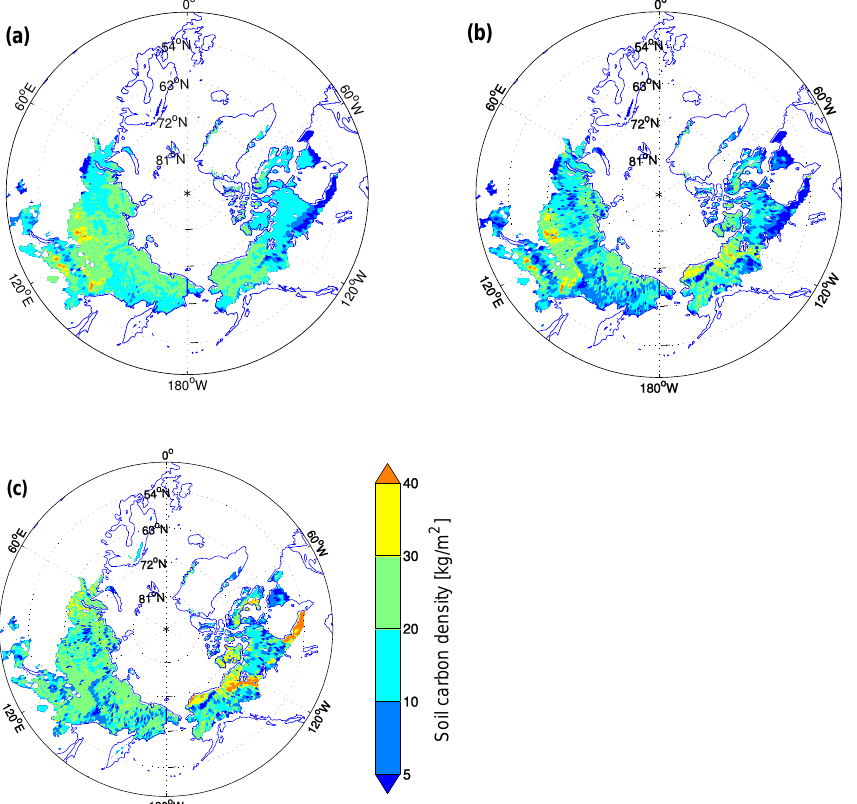
Figure 6. The soil carbon maps averaged over top 3m: (a) from SiBCASA at the end of the steady-state run with constant permafrost carbon density, (b) from SiBCASA at the end of the steady-state run with spatially varying permafrost carbon density, and (c) from the